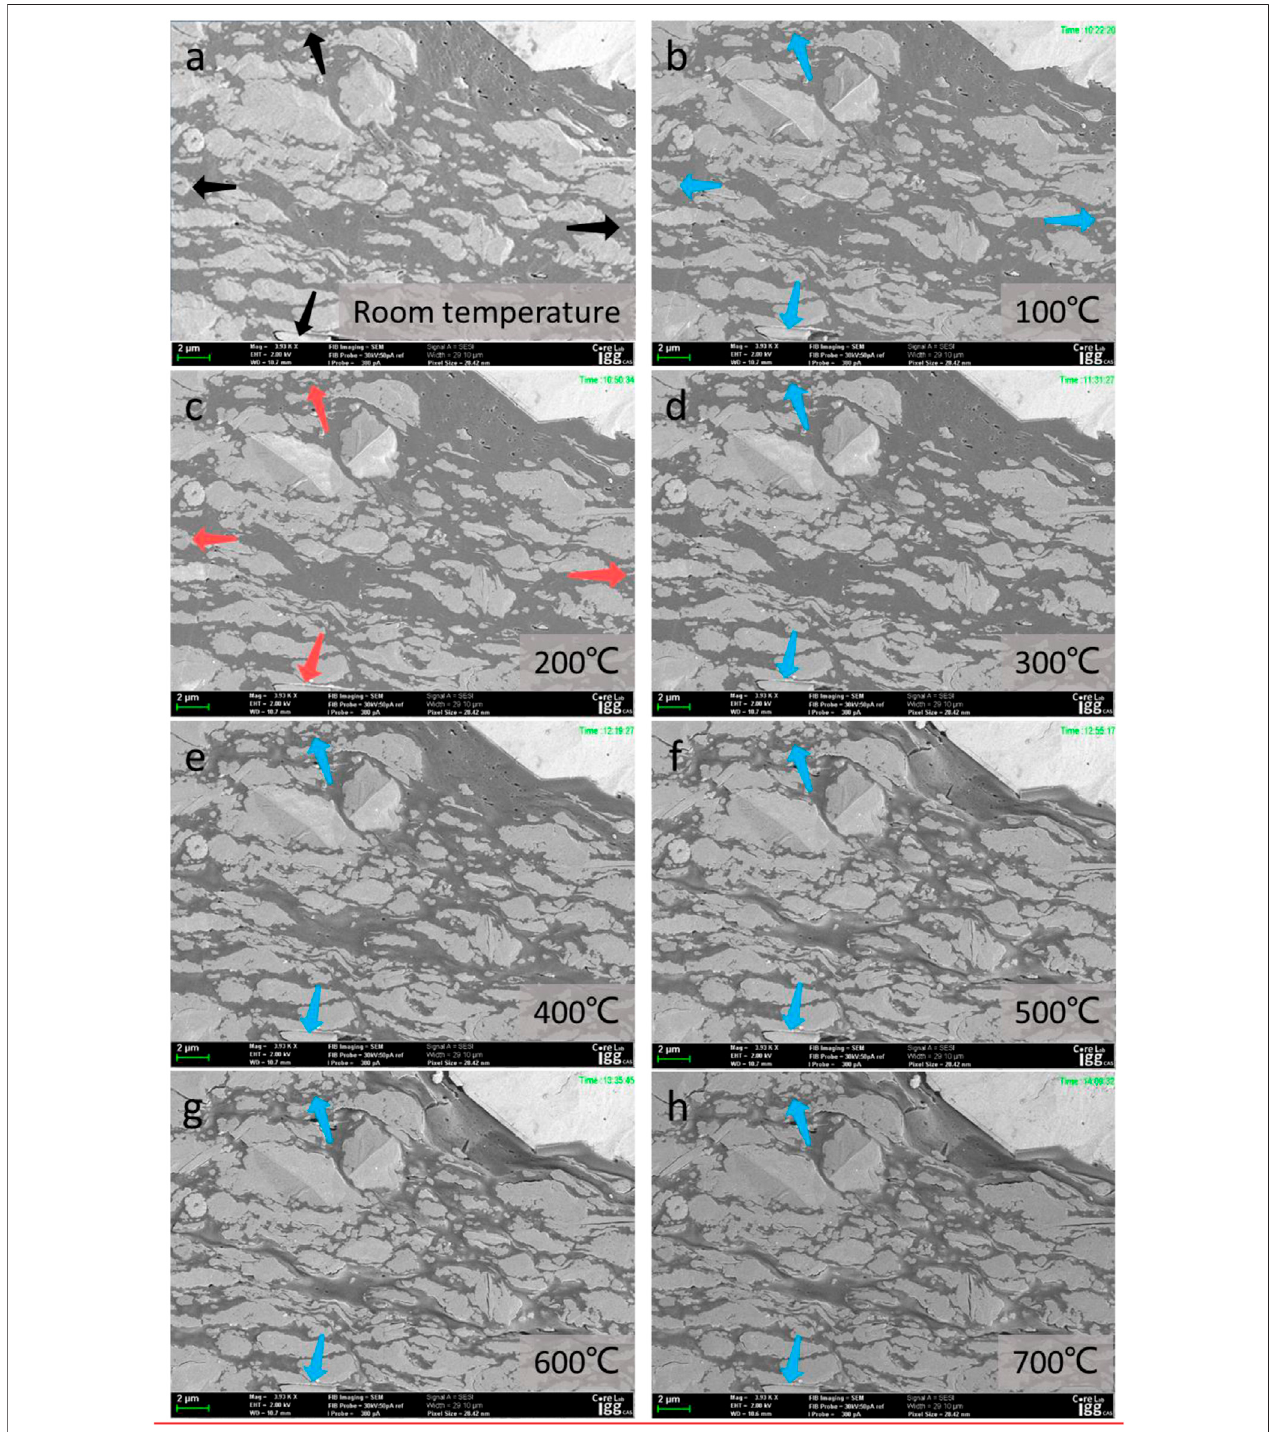
FIGURE6| SEMimagesofone fi eldofviewusingthesame magni fi cationateightdifferenttemperatures. (A) Blackarrowssquaresindicatecharacteristicparticles usedforcomparison. (B – H) Bluearrowsshowtheinwardmovementofcharacteristicparticles,indicatingsampleshrinkage.Redarrowsshowtheoutwardmovementof characteristic particles, indicating sample expansion.